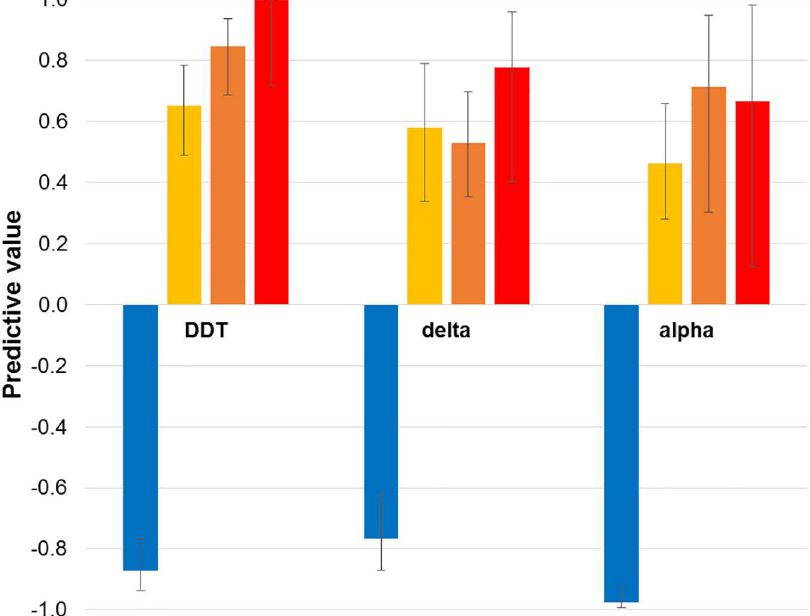
Fig 2. Positive and negative predictive values for DDT resistance and pyrethroid tolerance for each Vgsc -1014genotype group. delta = deltamethrin; alpha = alpha-cypermethrin. Error bars are 95% confidenceintervals.